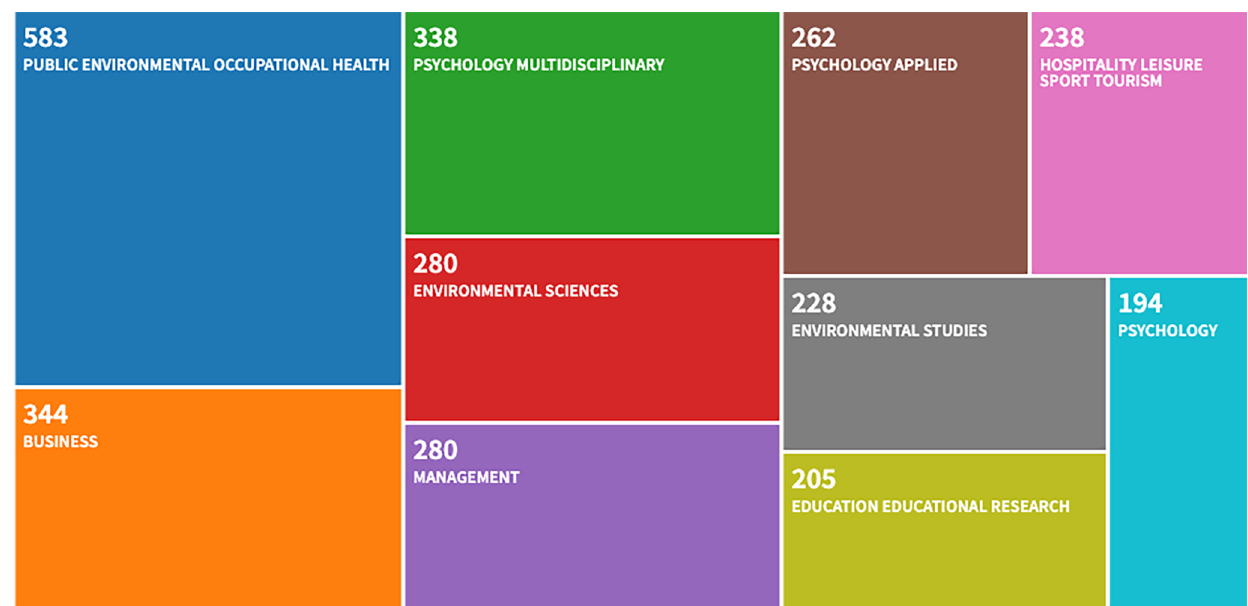
Figure 1. Treemap of the behavioral domains in which the theory of planned behavior has been used according to the Web of Science bibliographic database (as of April 2020). 2952 out of 4230 manuscripts could be assigned to the ten most covered thematic